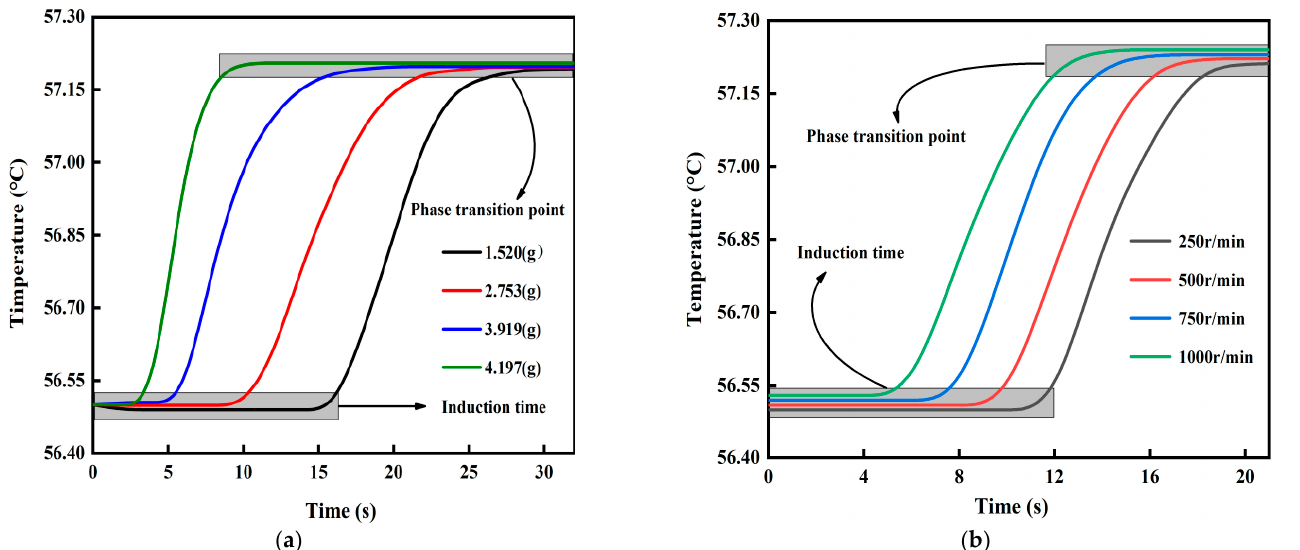
Figure 5. CPCM ‐ induced crystallization at speed of 750 r/min ( a ) and when the mass is 2.753 g ( b ).